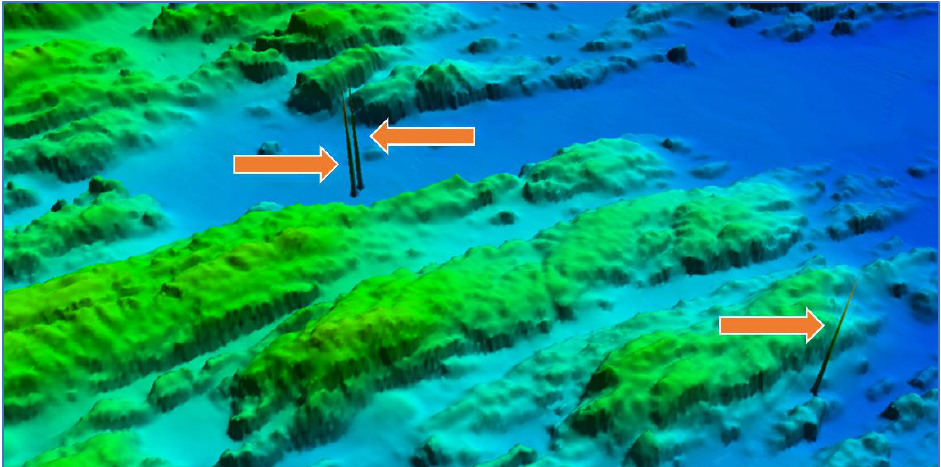
Figure 1. Depth fliers (pointed out by the orange arrows) of a few meters in a bathymetric grid with an average depth of 50 m. Though no algorithm can distinguish them from the natural seafloor with 100% accuracy, human reviewers are aided greatly by automated scanning to flag suspect areas. Image obtained using CARIS HIPS and SIPS software.